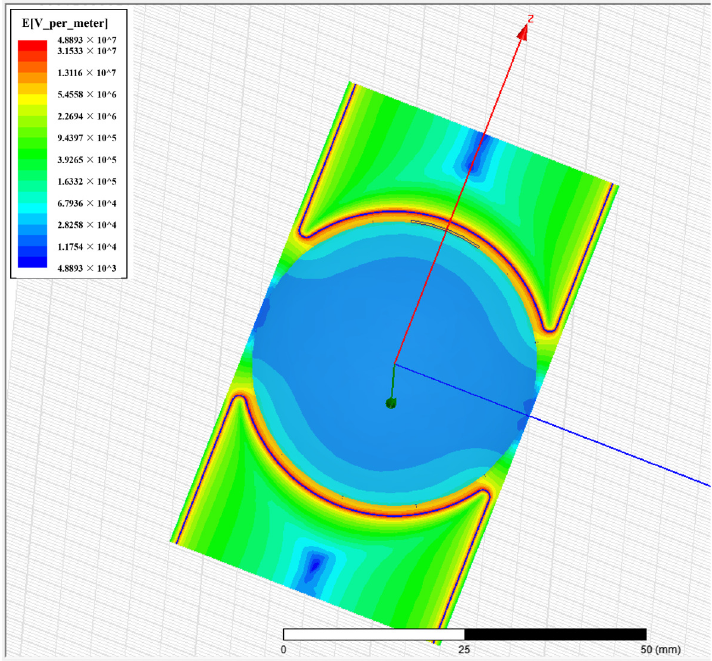
Figure 5. Simulation analysis of egg electric field distribution with